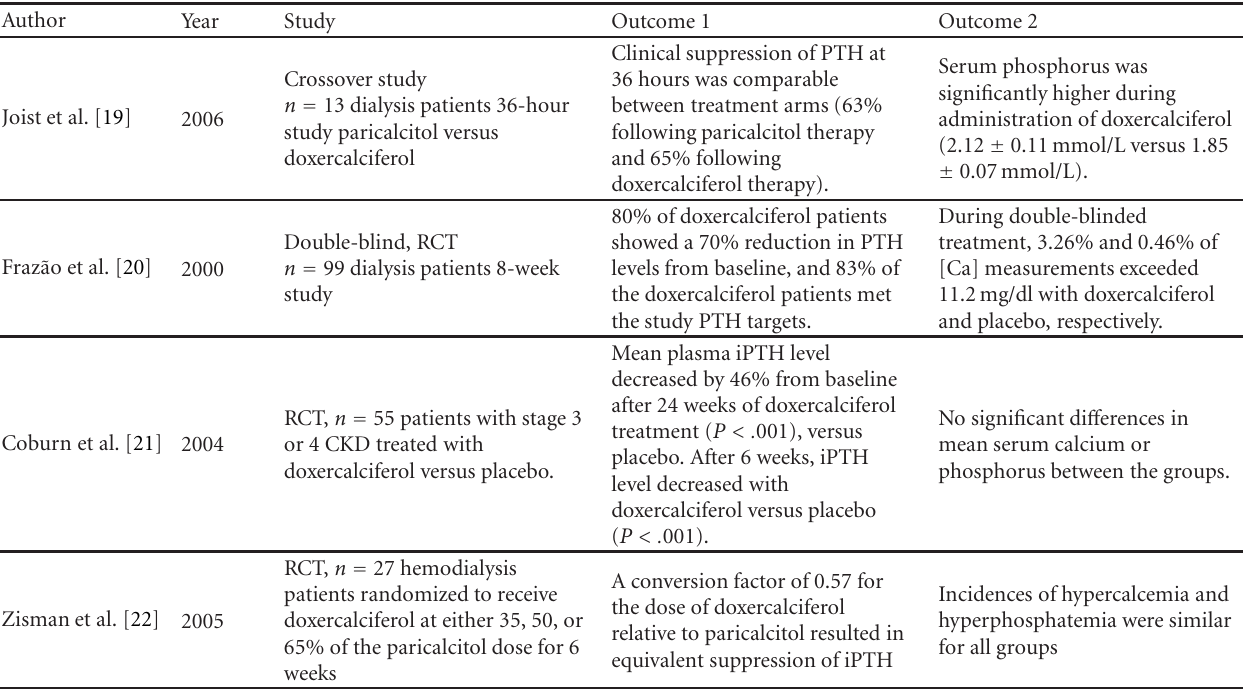
Table 3: Suppression of PTH and e ff ects on calcium and phosphate levels: doxercalciferol versus placebo and doxercalciferol versus paricalcitol.